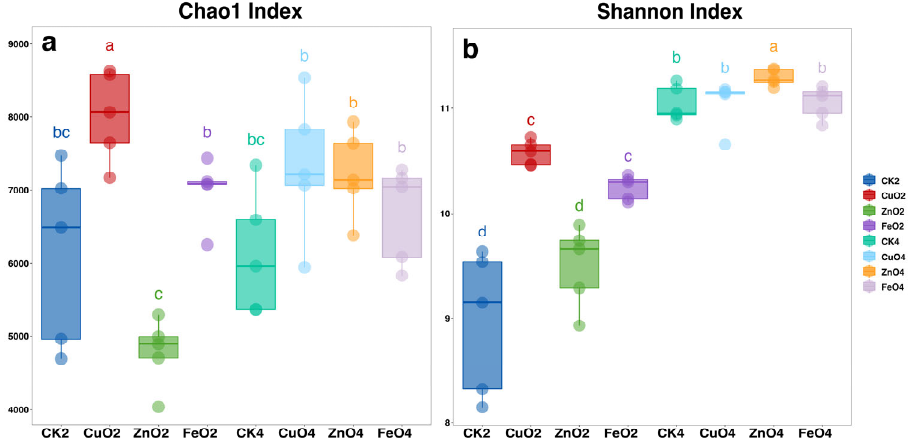
Figure 3. Chao1 ( a ), Shannon ( b ) index under the exposure of CK, CuO, FeO, and ZnO NPs. Different letters reveal the significance among different treatments ( p < 0.05). The horizontal bars within boxes represent medians. The tops and bottoms of boxes represent the 75th and 25th percentiles, respectively. The upper and lower whiskers extend to data no more than 1.5× the interquartile range from the upper edge and lower edge of the box, respectively. Abbreviation: second week of nanoparticles treatment (Control 2 , CuO 2 , ZnO 2 , and FeO 2 ), fourth week of nanoparticles treatment (Control 4 , CuO 4 , ZnO 4 , and FeO 4 ). In addition, CuONPs and FeONPs significantly increased the Shannon index in the second week (Figure 3b), while ZnONPs had no significant difference. In the fourth week, only ZnONPs significantly increased the Shannon index ( p < 0.05). Interestingly, the Shannon index showed a significant increase overall ( p < 0.05) compared with the second